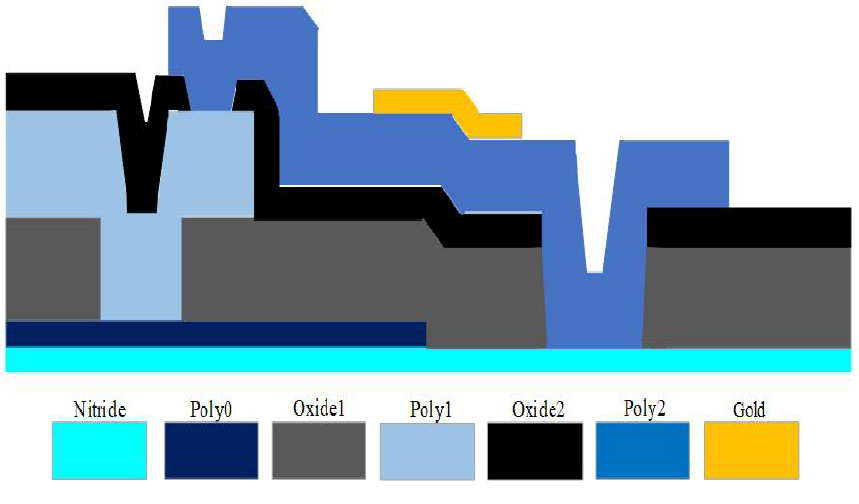
Figure 4. Cross-sectional sketch for the seven layers of the PolyMUMPs